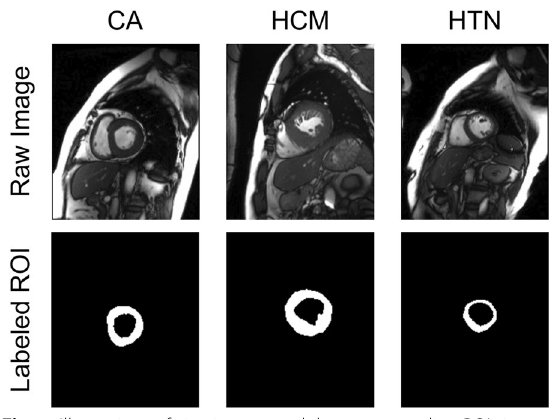
Fig. 7 Illustrations of cine images and the corresponding ROIs in Model 3 of different LVH